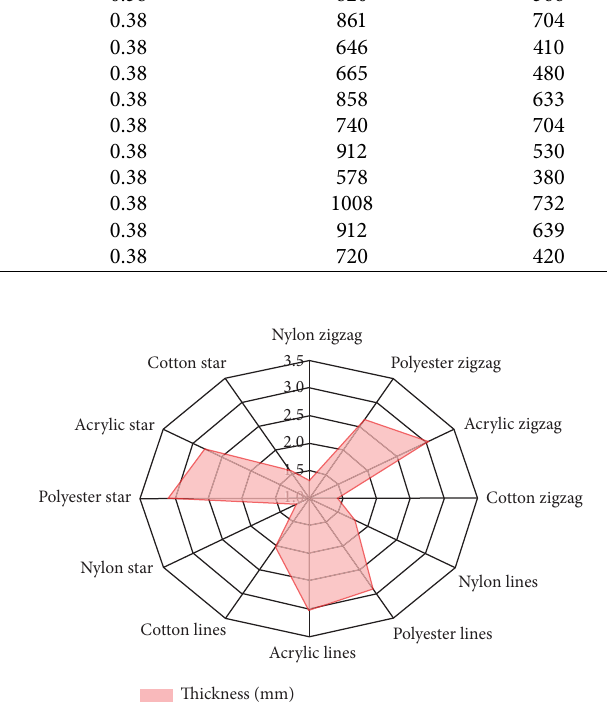
Figure 11: Tickness (mm) of auxetic specimens.